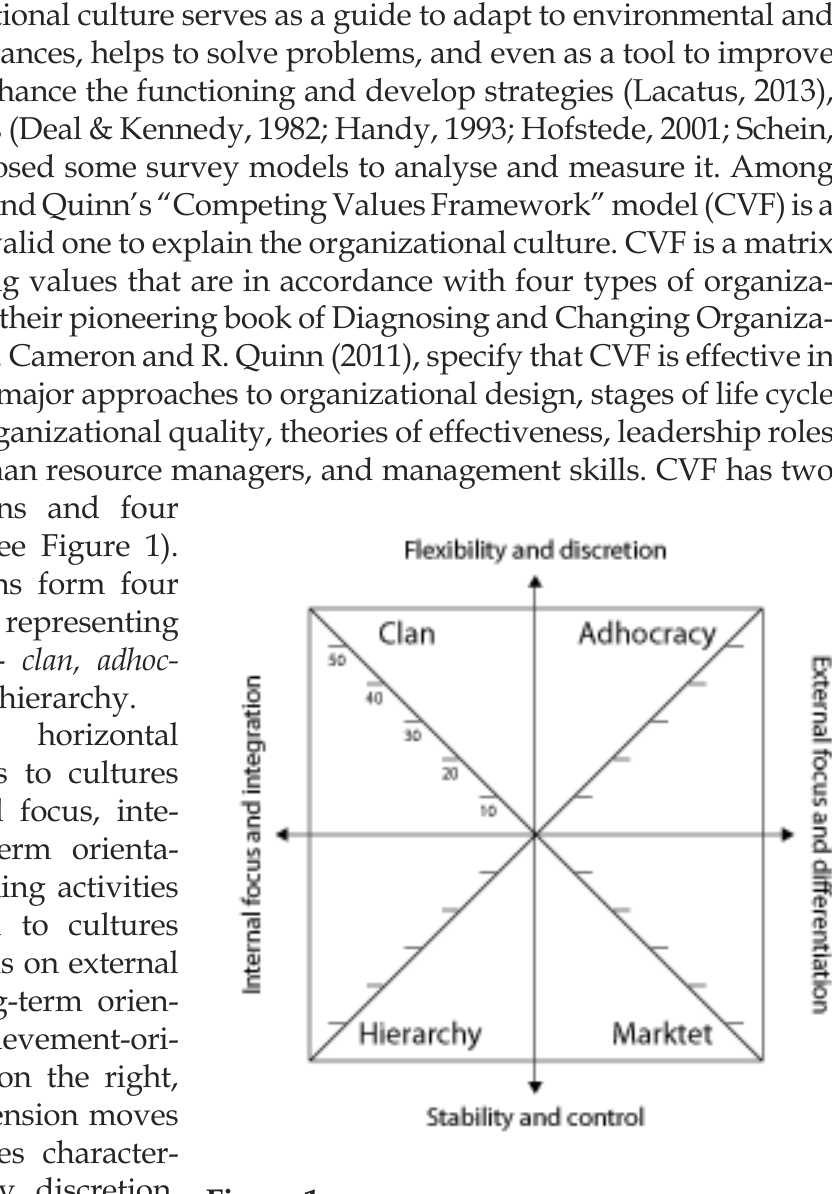
Figure 1. The Competing Values Framework Source: K. Cameron and R. Quinn,